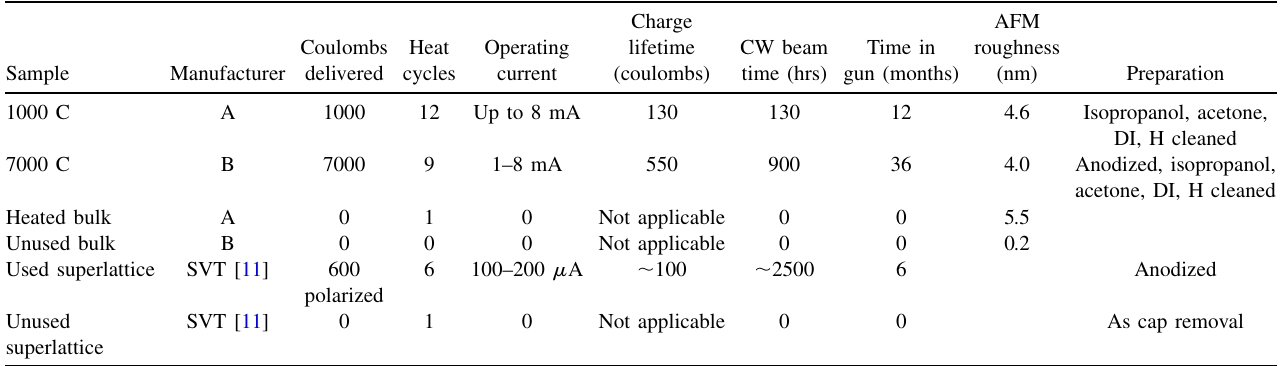
TABLE I. List of photocathode